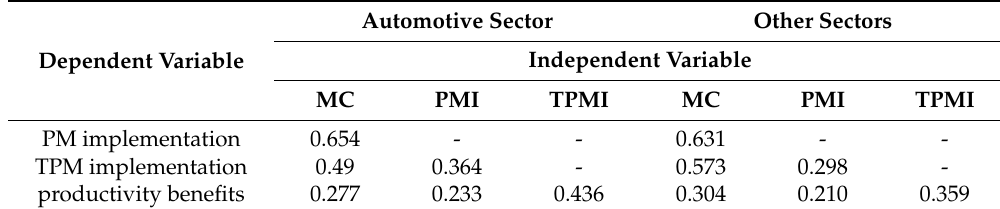
Table 11. Beta values for models.